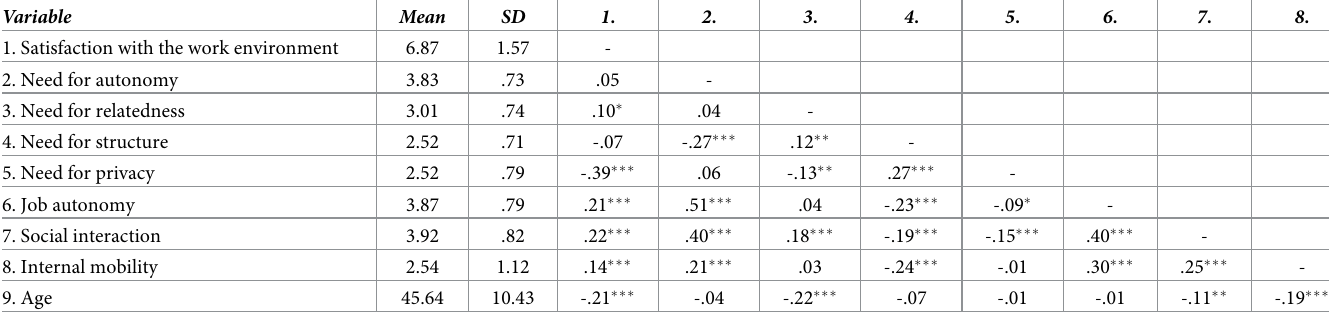
Table 2. Descriptive statistics for the included continuous